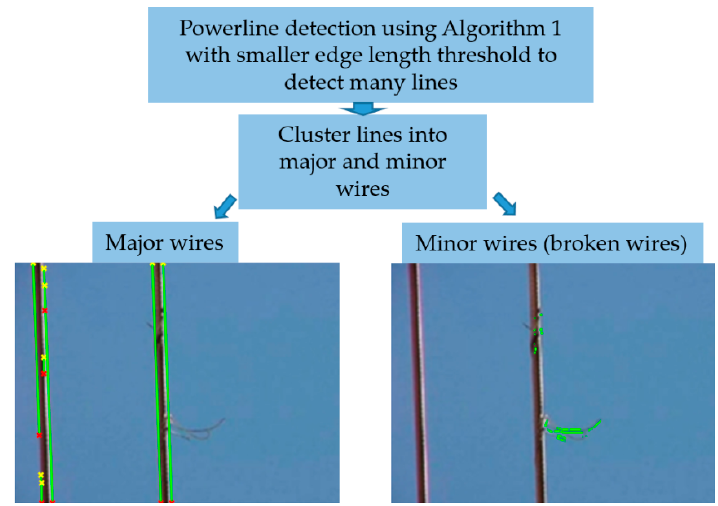
Figure 9. Schematic of the broken power line detection algorithm.